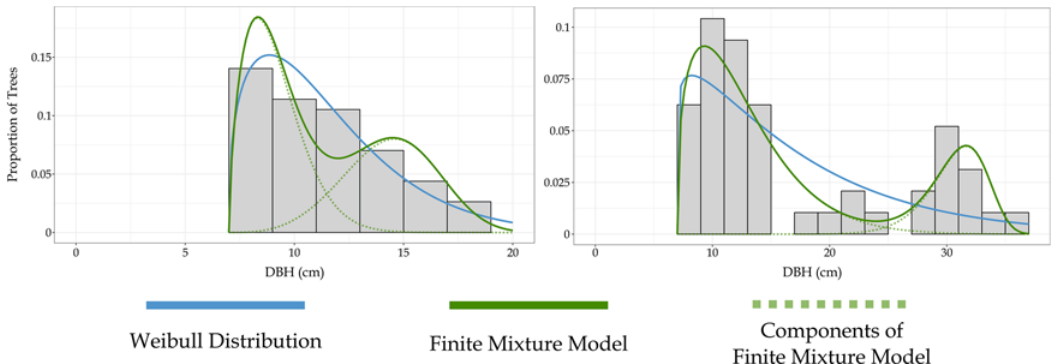
Figure 3. Weibull distributions (blue) best fit unimodal stands ( left ), while more complex distributions such as a Finite Mixture Model (green) best fit multimodal stands ( right ).